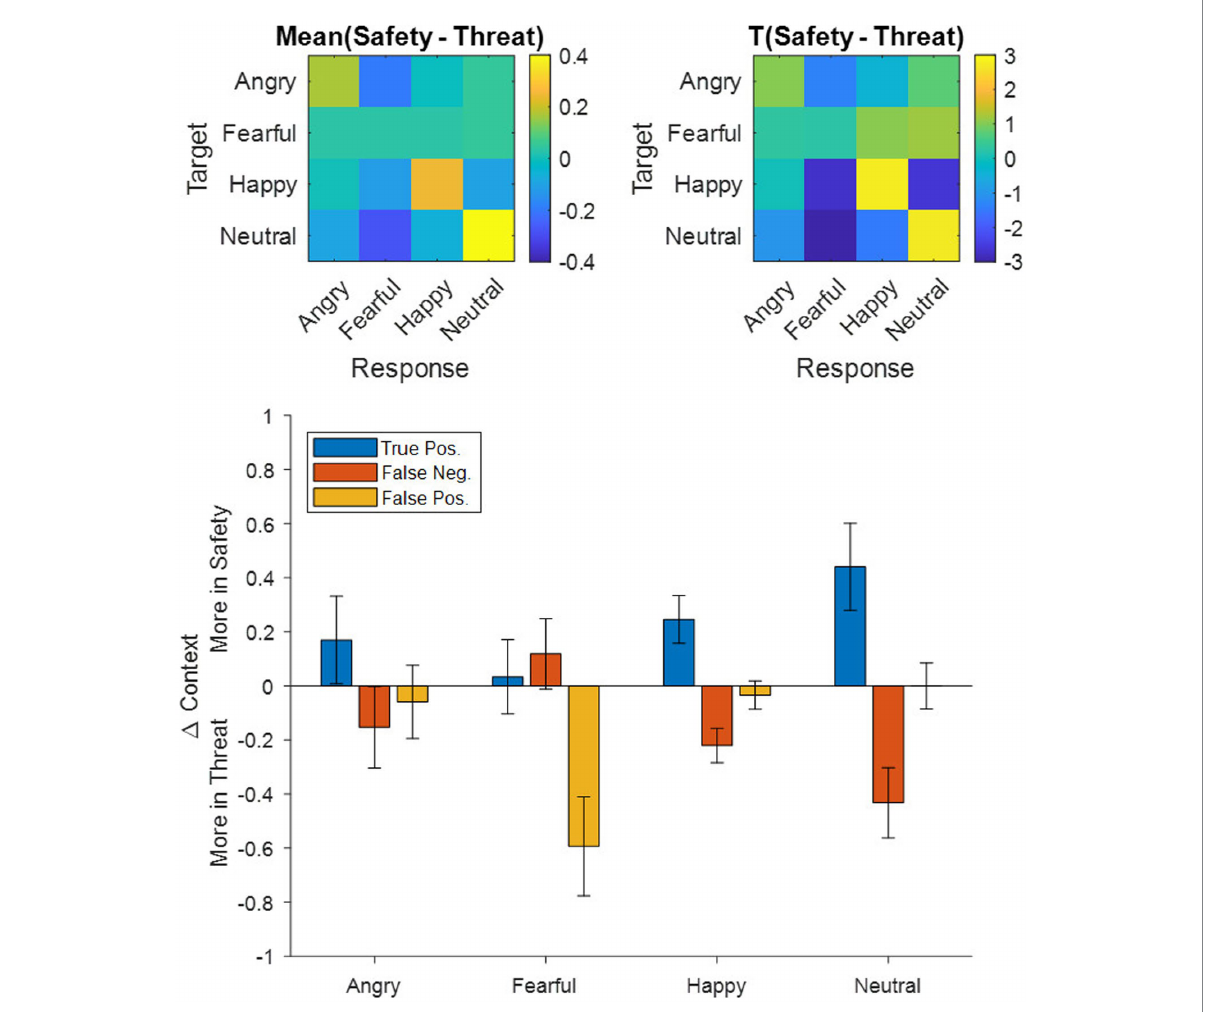
FIGURE 3 Top : Confusion matrices for ( left ) averaged group-level differences between the safety and threat contexts and ( right ) the corresponding t-scores depicting emotional expressions shown in the experiment (target) as rows and the corresponding responses of the participants as columns. Warm colors indicate more responses in the safety context, while cool colors indicate more responses in the threat context. Bottom : Breakdown of the group-averaged accuracy and precision results (ref. Figure 2) into their corresponding true positive, false negative, and false positive counts contrasted between contexts (i.e., Safety-Threat) as a function of the four emotional expressions. Error bars indicate standard error of the